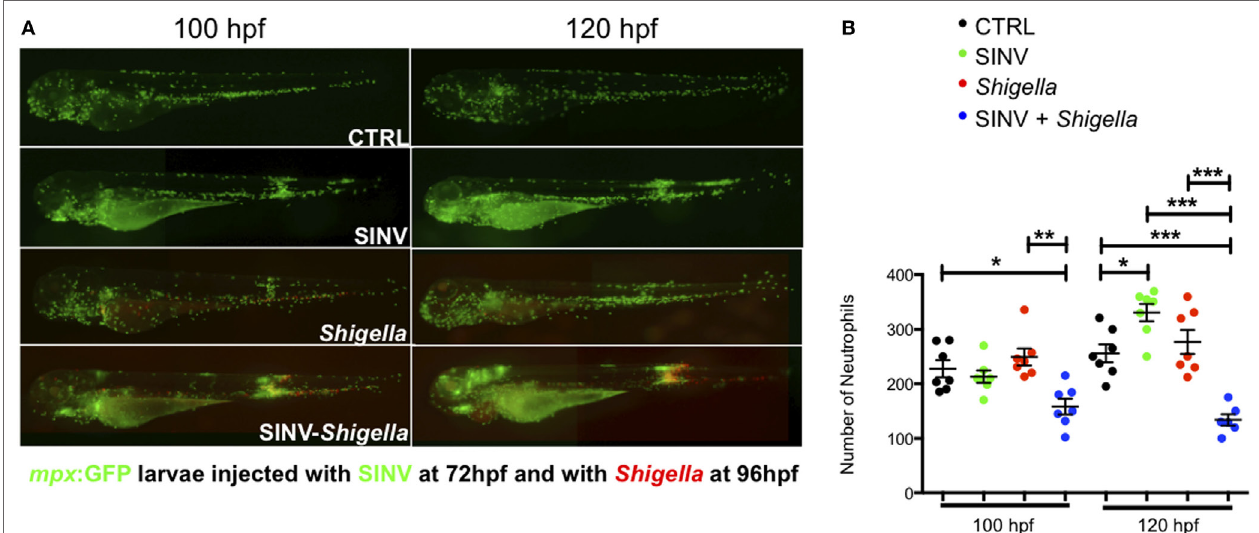
FigUre 3 | Impaired neutrophil counts upon Shigella injection in Sindbis virus (SINV) infected fish. (a) mpx :GFP zebrafish larvae (green neutrophils) were sequentially injected intravenously with sublethal doses of SINV-GFP at 72 hpf and the day after with sublethal doses of Shigella -DsRed. As a control, similar doses of SINV-GFP only and Shigella DsRed only were injected in the blood of 72 and 96 hpf mpx :GFP larvae, respectively. The infected larvae were then imaged with a wild field fluorescent microscope over time at 100 hpf (4 h post Shigella injection) and at 120 hpf (24 h post Shigella injection) to monitor the impact of the co-infection on the neutrophil population at the level of the entire organism. Note that it was possible to discriminate under the microscope the GFP label of the SINV-GFP infected cells (diffuse and less bright) from the GFP label of the mpx :GFP neutrophils (brighter). The neutrophil numbers appeared to be decreased in SINV- Shigella co-infected larvae. Overlay of green (SINV and neutrophils) and red ( Shigella ) fluorescence from single or co-infected fish is shown. (B) Neutrophil counts in uninfected (CTRL, black symbols) or upon sublethal SINV-GFP (green symbols), Shigella -DsRed (red symbols) injection or sequential SINV + Shigella (blue symbol) injection. Neutrophils were counted from images taken on live infected larvae using ImageJ software, and plotted as specified in Section “Materials and Methods.” Mean ± SEM are also shown (horizontal bars). Data plotted are from two pooled independent experiments ( n = 7 larvae scored for each